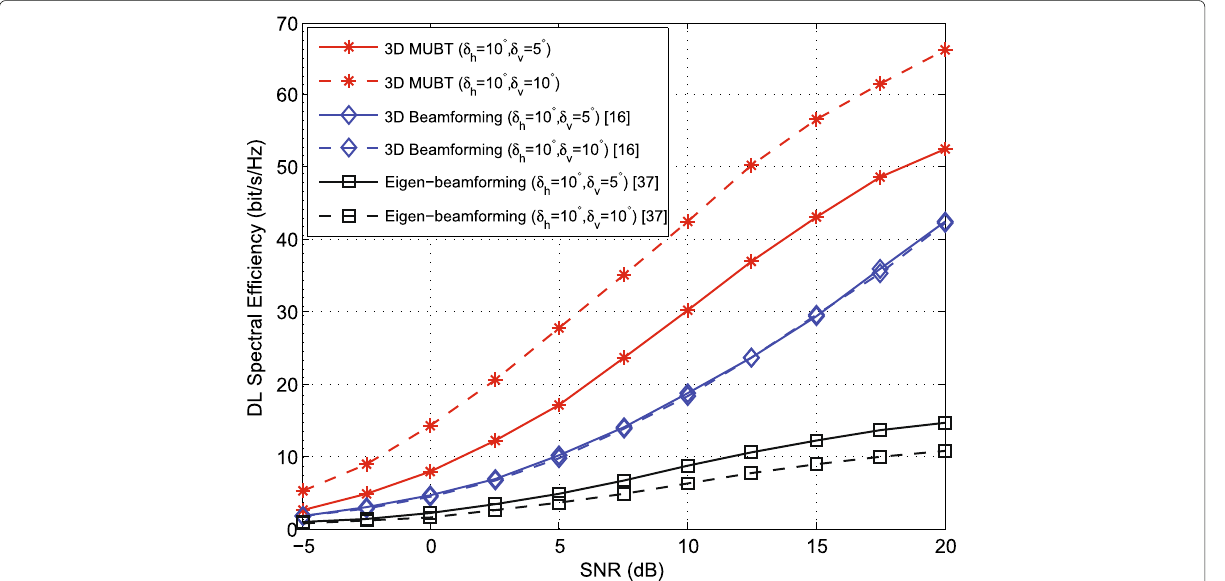
Fig. 8 SEs versus average DL receive SNRs in different 3D precoding